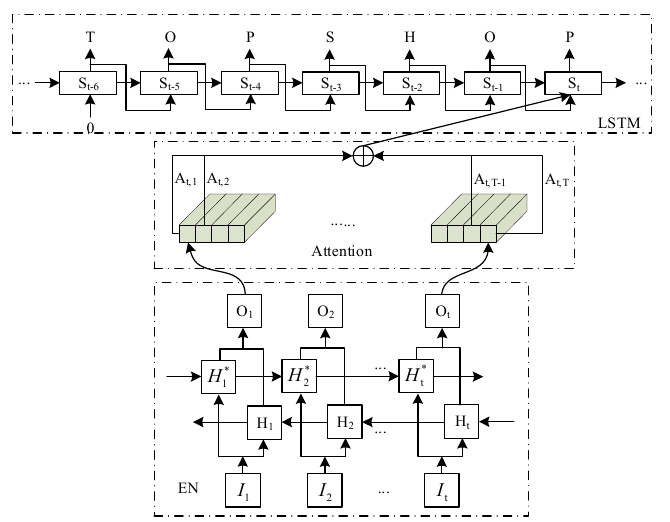
Figure 6. Detail structure on Decoder Network.